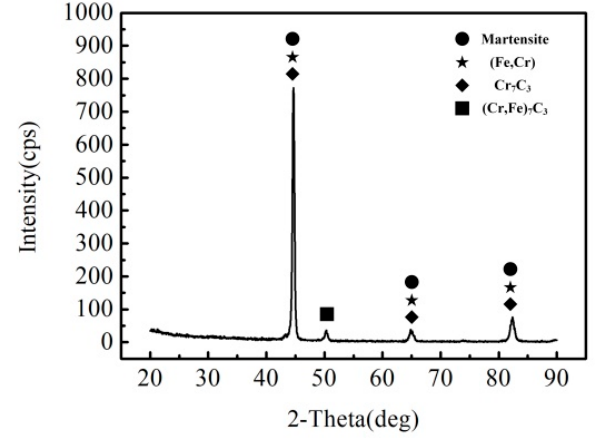
Figure 7. XRD of weld of 42CrMo4/38MnVS6 laser welded joint.